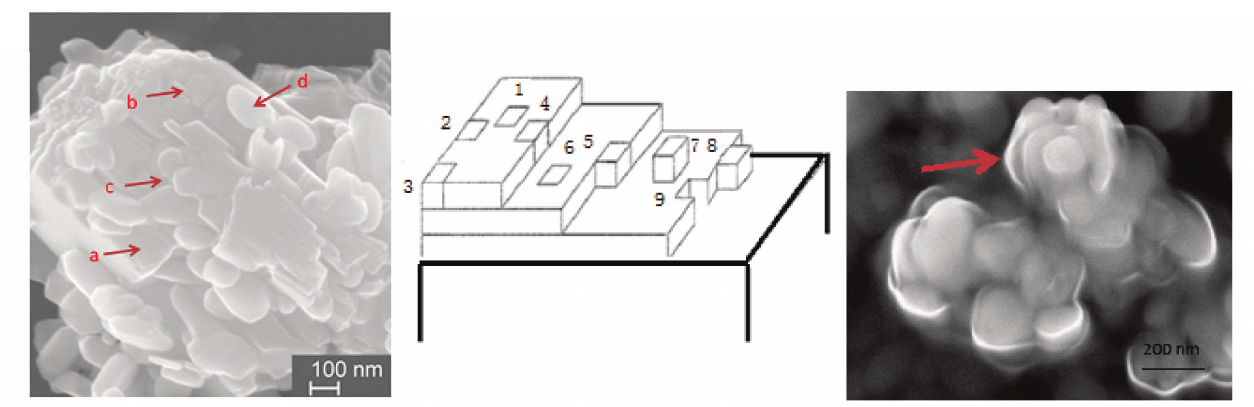
Figure 7. Sample recovered from impact with military rounds. Note the similarities between regions where IF have been added to an existent layered structure, such as a, b, c, and d ( left ) with sites proposed by crystal growth theories for addition matter in a surface ( center ). Particle showing layers that delaminated ( right